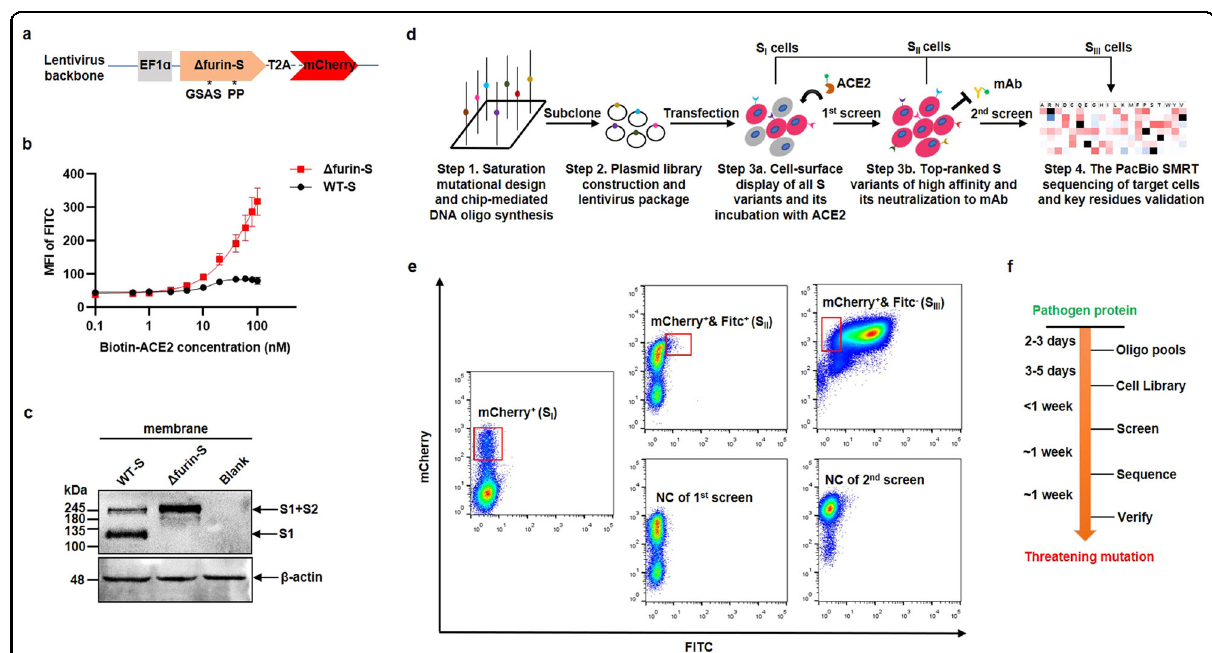
Fig. 1 The development of robust cell surface-display platform for high-throughput screening of S variants. a The backbone of lentivirus plasmid, in which S variant was fused with mCherry via a T2A linker. The expression of S variant was driven by the constitutive strong EF1 α promotor. b MFI of FITC in the WT-S and the Δ furin-S cell line, which were incubated with various concentrations of biotin-ACE2 (0, 0.1, 0.5, 1, 2.5, 5, 10, 20, 40, 60, 80, 100 nM). The non-linear regression curve (Sigmoidal, 4PL) was fi tted and the bars represented SD, n = 2. c Western blotting analysis of membrane protein samples that were extracted from the WT-S, Δ furin-S, and blank HEK293T cell line, respectively. The primary antibody targeted the S1 subunit. The MW of S (S1 + S2) and S1 was migrated as ~230 kDa and ~129 kDa due to glycosylation, respectively. β -actin (~42 kDa) was used as the loading control. d The fl owchart for high-throughput screening of S variants, from Step1 to Step 4. e The cell sorting graph, where the percentage of S I , S II , and S III cells (red rectangle) were ensured < 10%, 1% – 2%, and 5% – 10%, respectively. The middle and right bottom panel represented the negative control (NC) of the 1st and 2nd screen (both showing a clear background), with no ACE2 or mAb incubation,